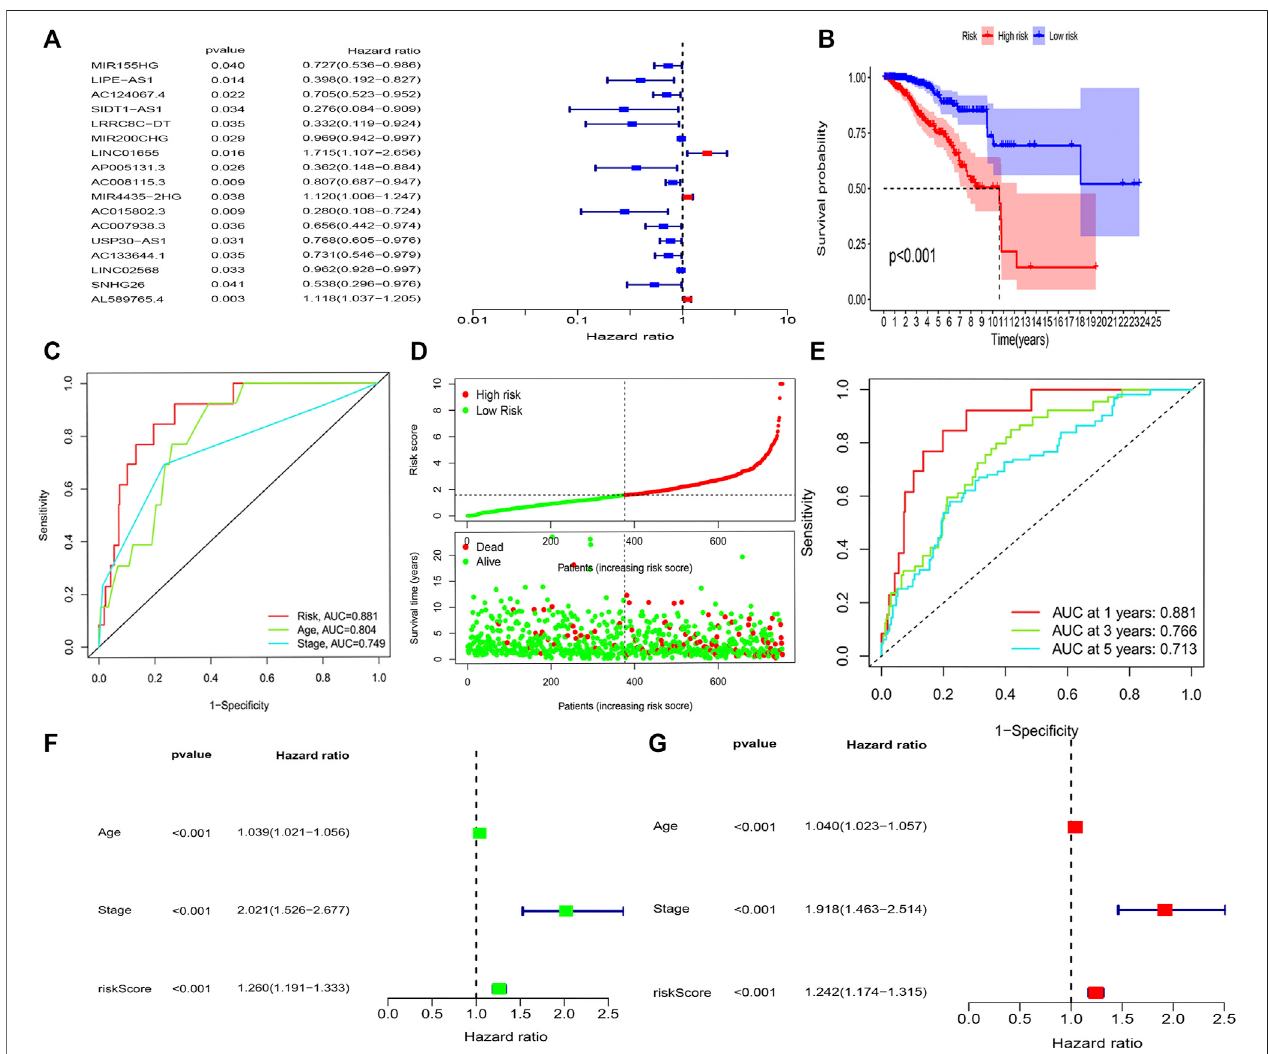
FIGURE3| Aminoacidmetabolism-associatedlncRNAsignaturebasedontrainingsets. (A) Univariatecoxanalysis (B) Kaplan – Meiercurves, (C) multi-indexROC analysis, (D) riskscore,and (E) time-dependentROCanalysis.UnivariateandmultivariateCoxanalysesoftheexpressionofAAM-relatedlncRNAs. (F) Univariateand (G) multivariate